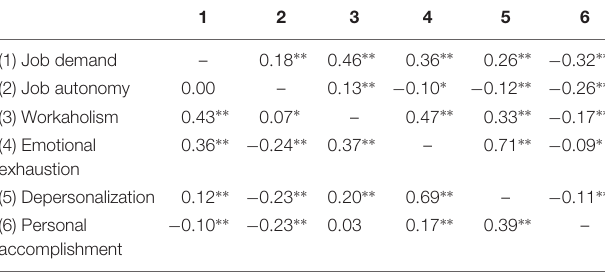
TABLE 5 | Correlation table - service industry.